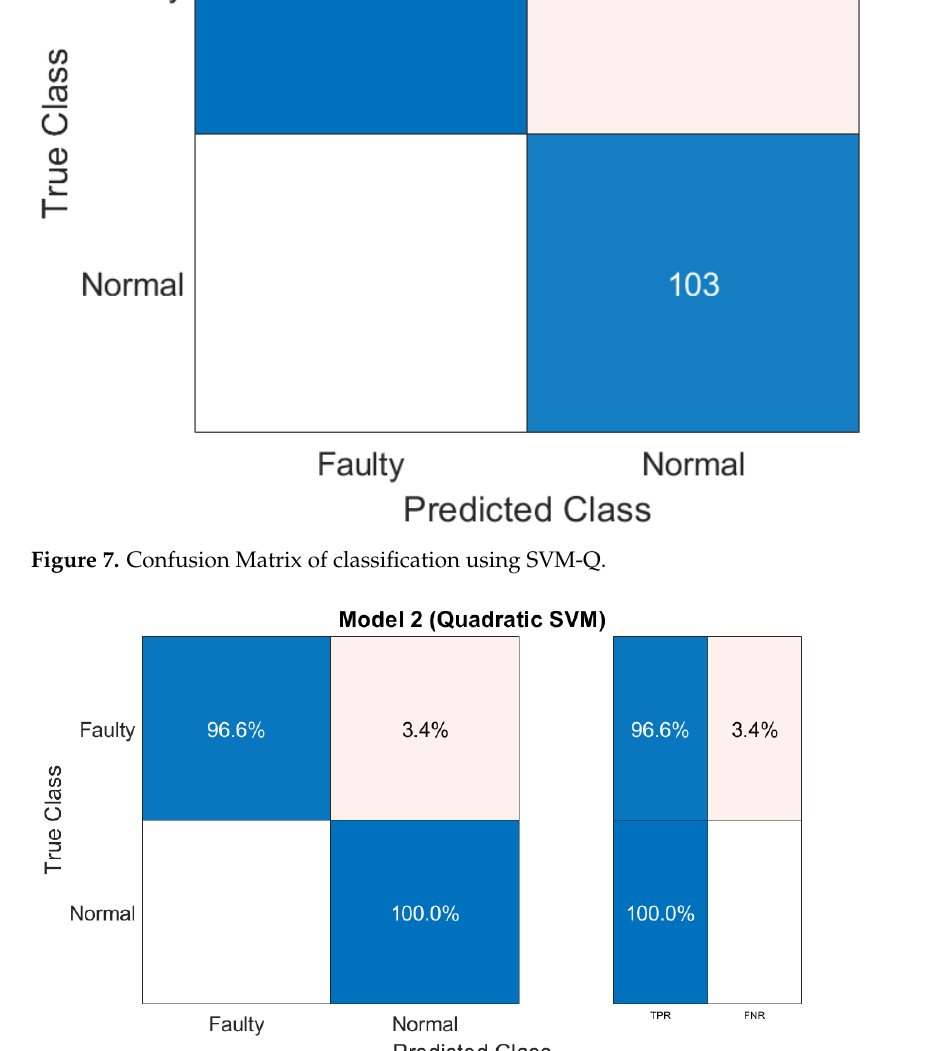
Figure 8. Confusion Matrix in terms of sensitivity and